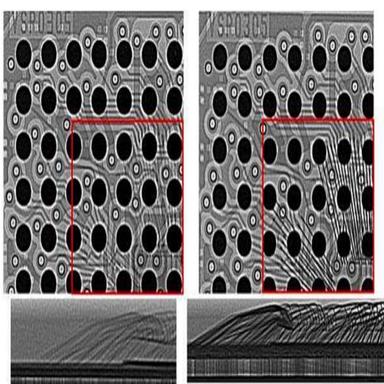
X-ray image with a counterfeit in a BGA package. On the left side, there is a fake copper bonding wire, while on the right side, there is the original gold bonding wire.